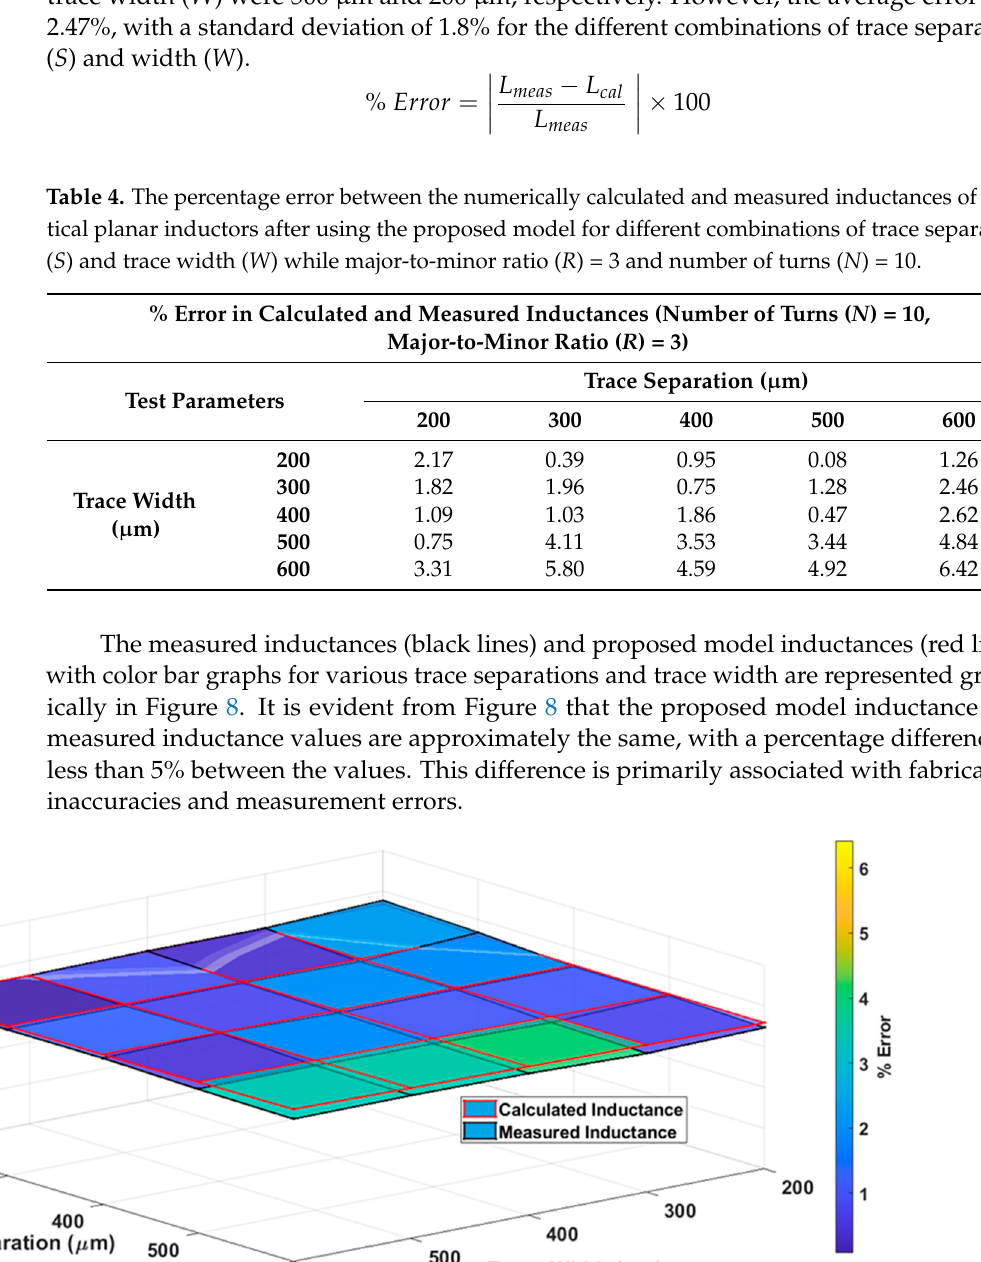
Figure 8. Surface plot of proposed model inductances and measured inductances of the elliptical planar inductor with a color bar to represent the percentage error for different combinations of trace separation ( S ) and trace width ( W ) while major-to-minor ratio ( R ) = 3 and number of turns ( N ) = 10. To evaluate the impact of the number of turns of the elliptical inductor on varying trace separation and trace width, five-turn elliptical inductors were investigated. The fabricated elliptical inductors with five turns are shown in Figure 9. For a fair comparison with previous results, trace separation and trace width combinations were kept the same as in the last test setup. The calculated and measured inductance values are tabulated in Tables 5 and 6, respectively. The maximum value of the calculated inductance was found for a trace width and trace separation of 200 µ m, and the minimum inductance value was seen for a trace width of 600 µ m and trace separation of 400 µ